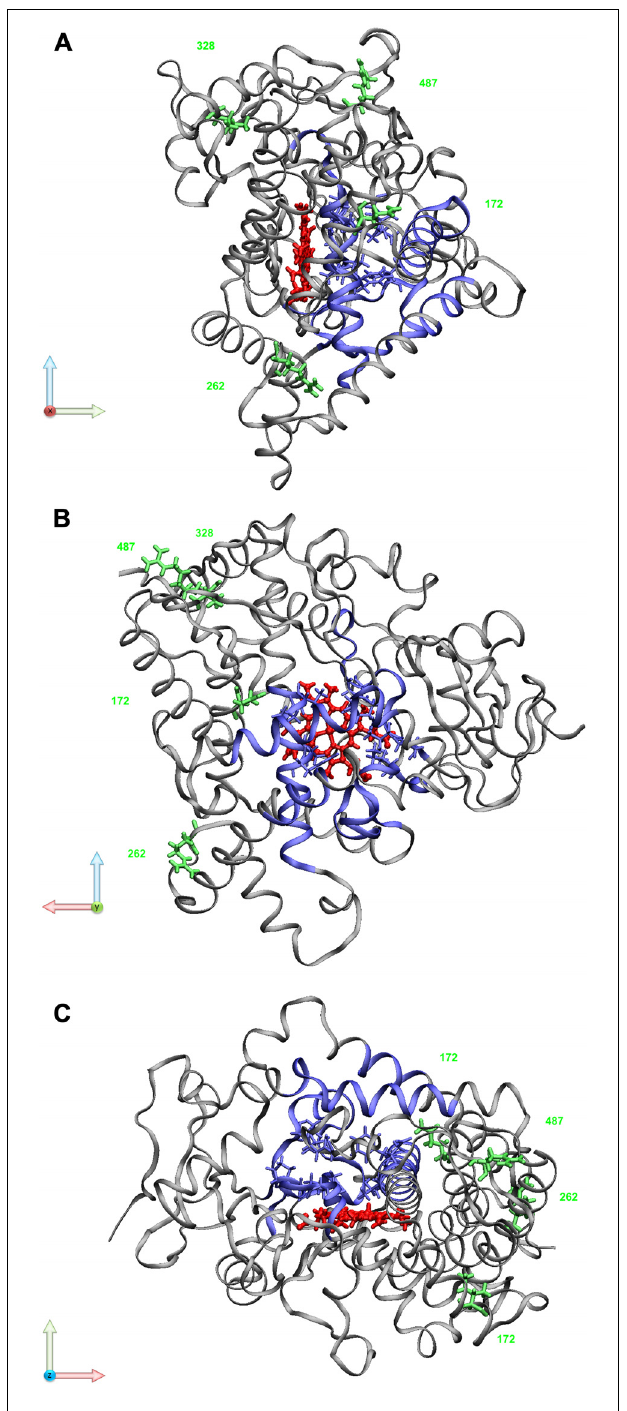
FIGURE 2 | CYP2B6 structural model. Selected variant residues are marked in green (Q172H, K262R, I328T, R487C); substrate recognition sites (SRS; Nguyen etal., 2008) and active site residues (ASR; Niu etal., 2011) are highlighted in blue; the prosthetic heme molecule is shown in red. PDB file 3IBD was visualized usingVMD visual molecular dynamics viewer http://www.ks.uiuc.edu/Research/vmd/ (Humphrey etal., 1996).The protein sequence used for determining the crystal structure contains R at position 262 instead of the reference residue K. (A) view along x -axis (light red); (B) view along y -axis (light green); (C) view along z -axis (light